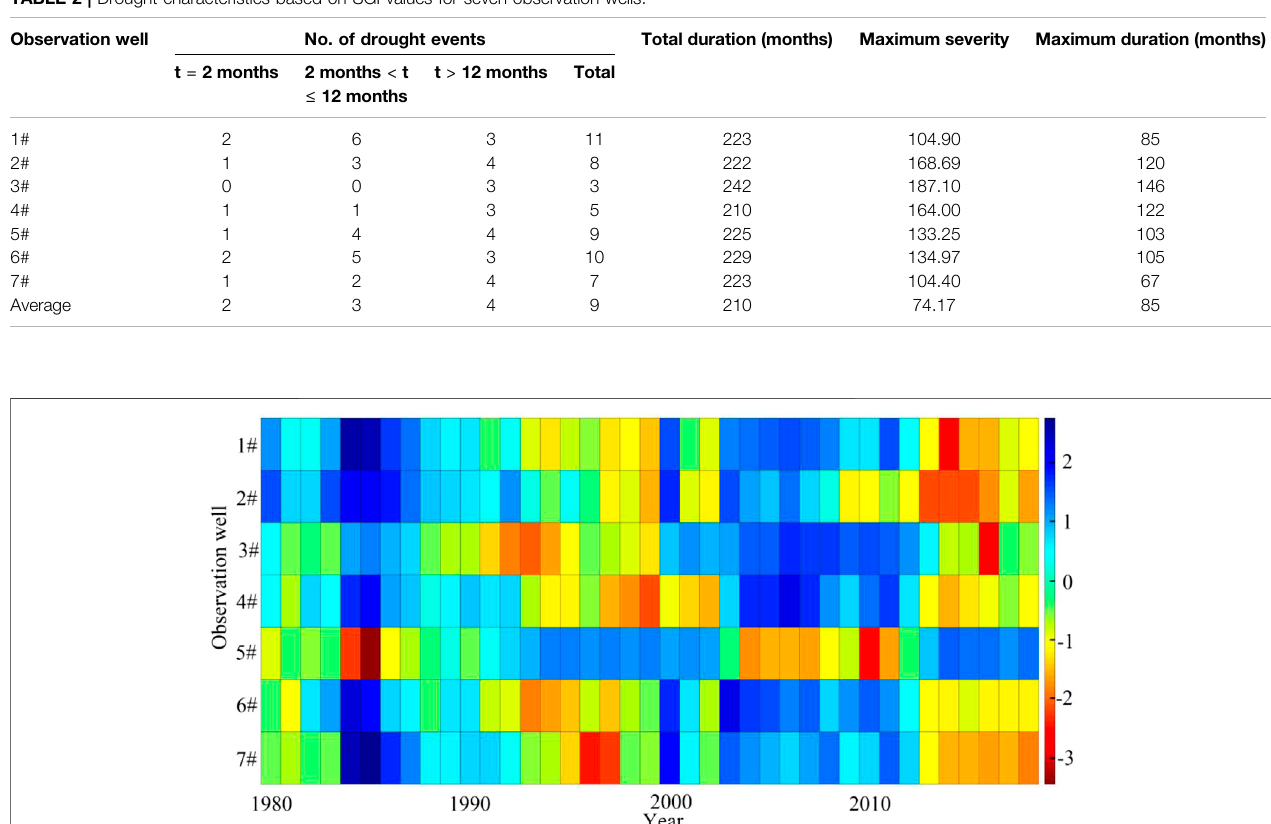
FIGURE 4 | Interannual variation of groundwater drought for all seven